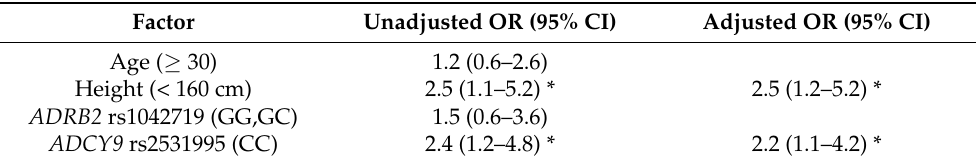
Table 5. Multivariable analysis of adverse drug